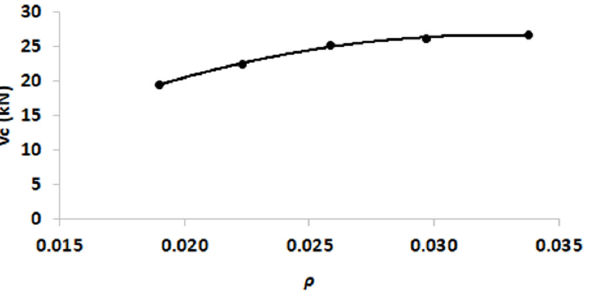
Figure 11. The effect of reinforcement ratio ( ρ ) on shear strength of HVFA ‐ SCC beam.